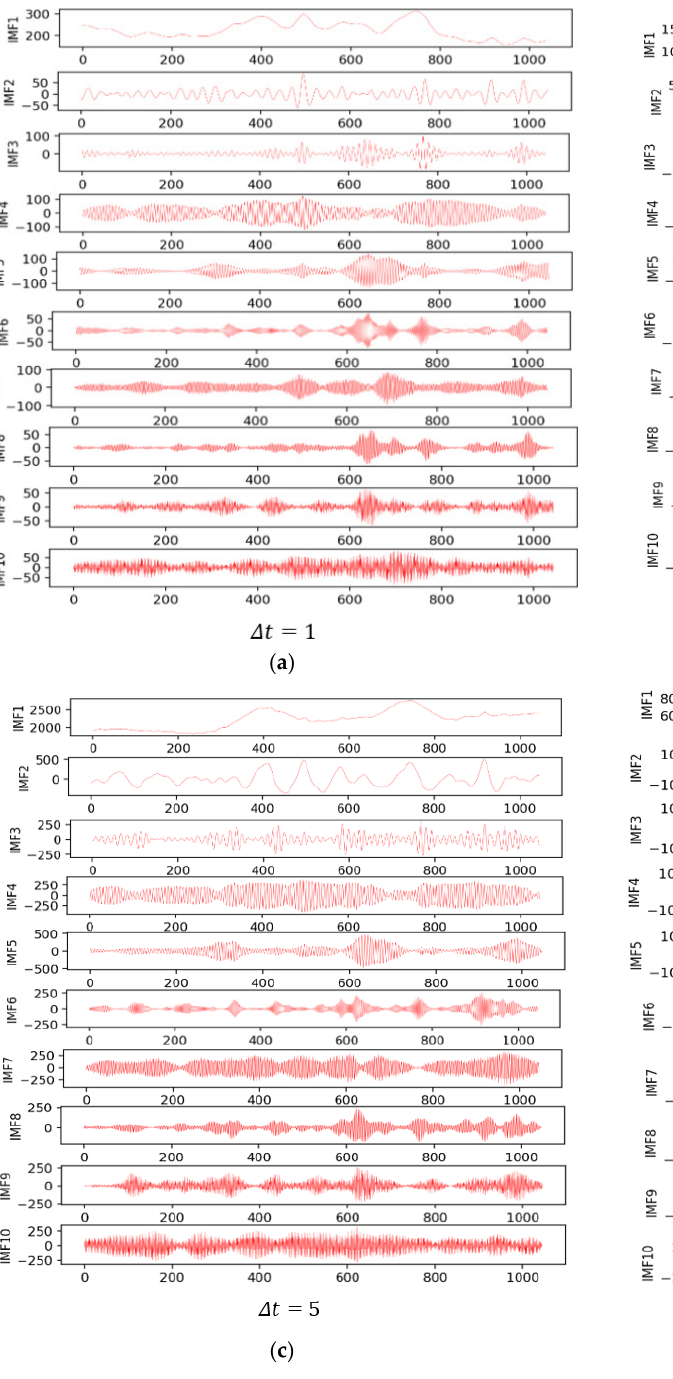
Figure 6. VMD decomposition results of Guangzhou South railway station–Zhuhai railway station (period 1). ( a ) VMD decomposition results under time granularity ∆ t = 1, ( b ) VMD decomposition results under time granularity ∆ t = 3, ( c ) VMD decomposition results under time granularity ∆ t = 5, ( d ) VMD decomposition results under time granularity ∆ t =